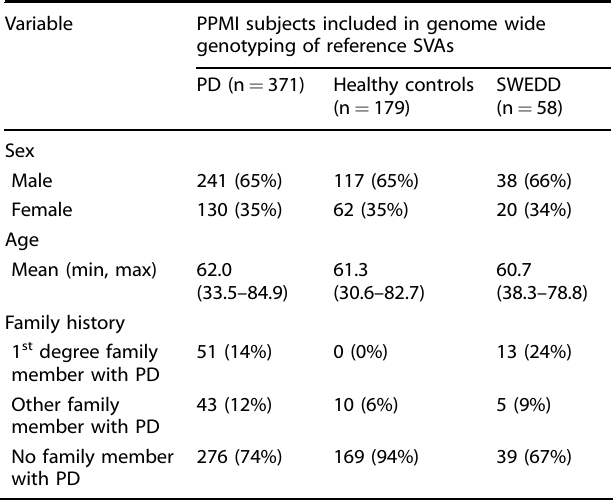
Table 1. Demographics of the PPMI